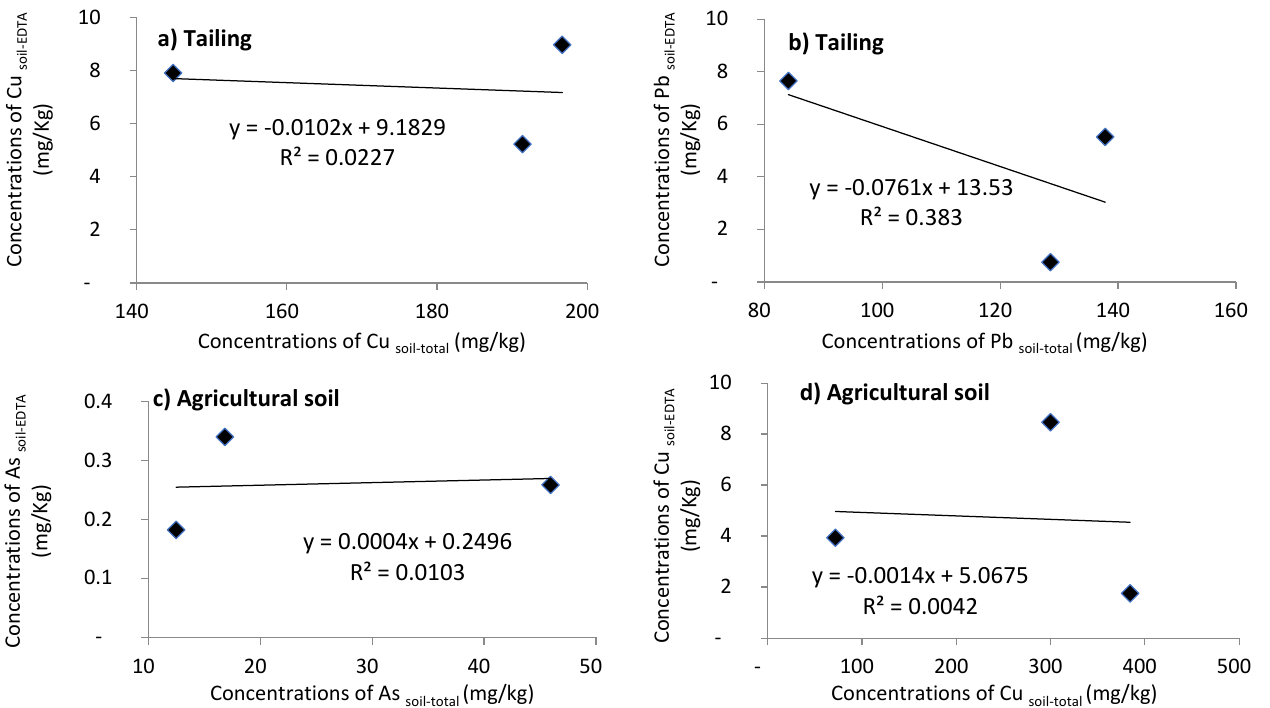
Figure 2. Correlation between total ( a ) Cu and ( b ) Pb content and its bioavailable fractions in tailings, and the correlation between total ( c ) As and ( d ) Cu content and its bioavailable fractions in agricultural soil.